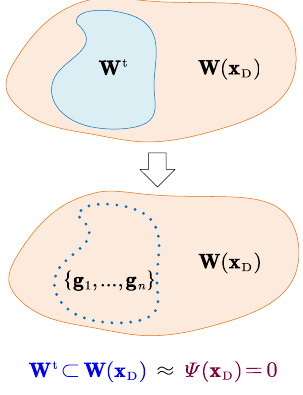
Figure 5. Schematic diagram of constraint simplification.